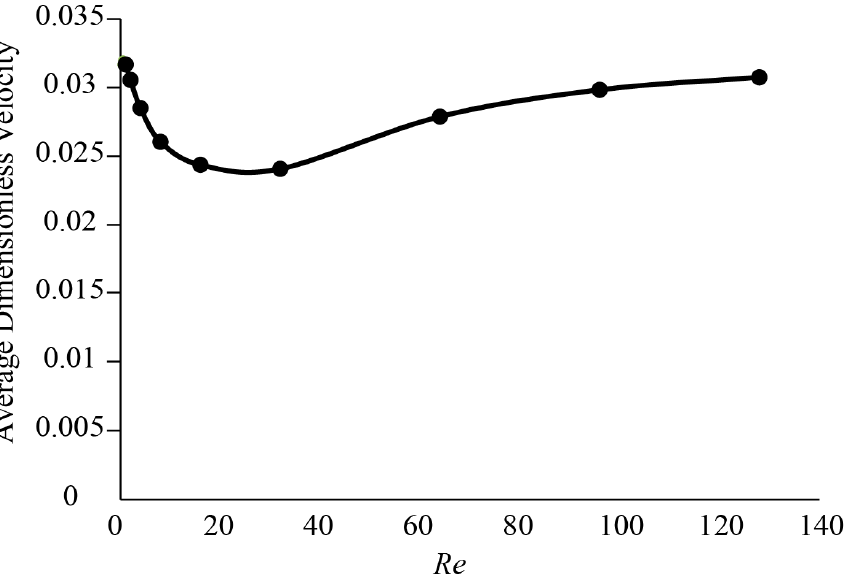
Figure A1. The average dimensionless y-component of velocity at mid-stroke (aoa = 45°). The velocity is averaged over a 0.2 m × 0.2 m × 0.3 m region surrounding the wing.